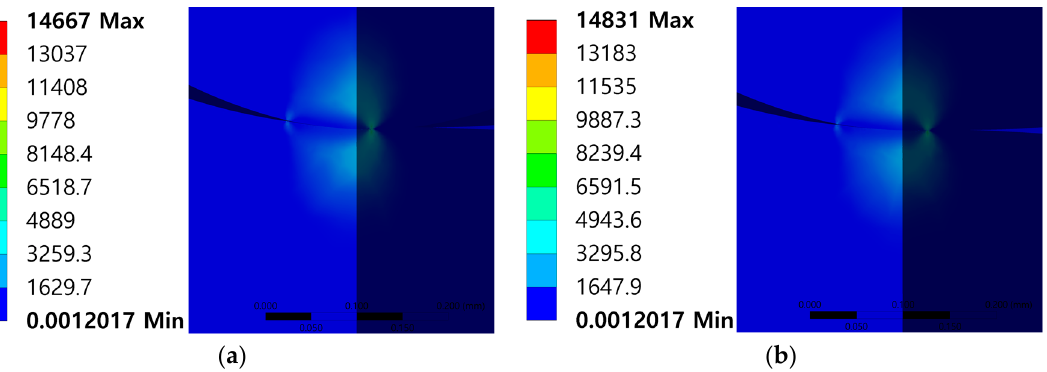
Figure 11. Equivalent stress (von Mises) results of contact condition applied model: ( a ) Pure penalty; ( b ) Augmented Lagrange.